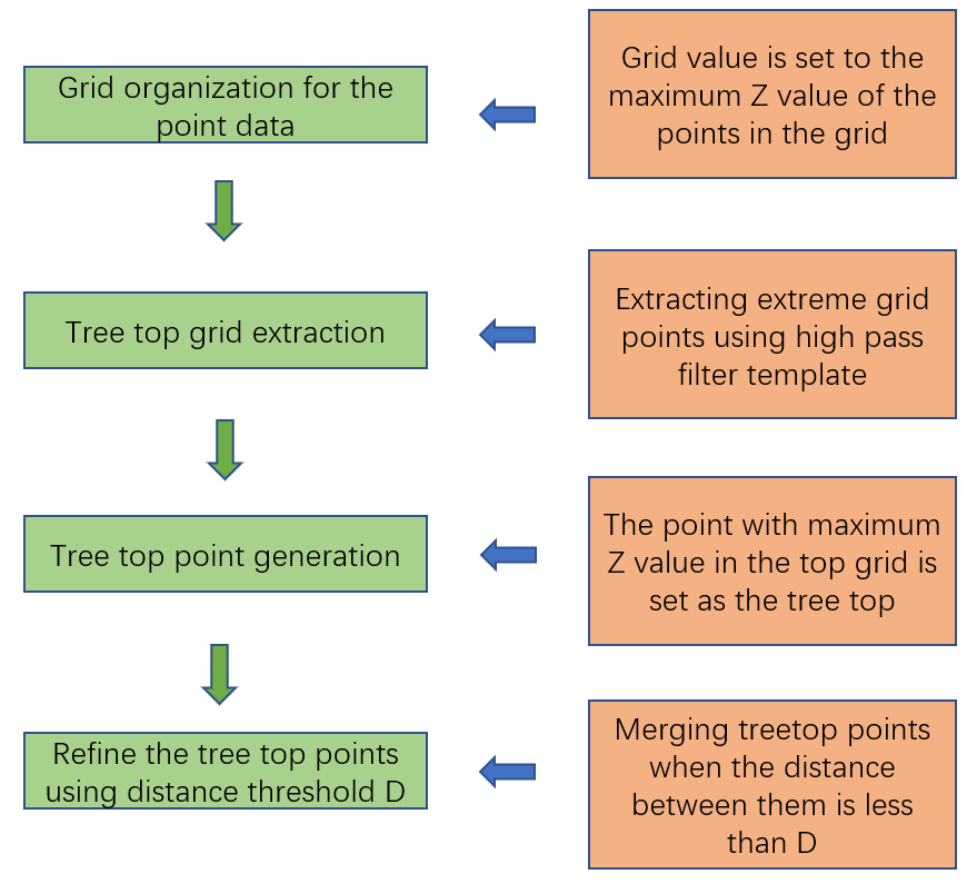
Figure 6. The workflow of original treetop points generation.